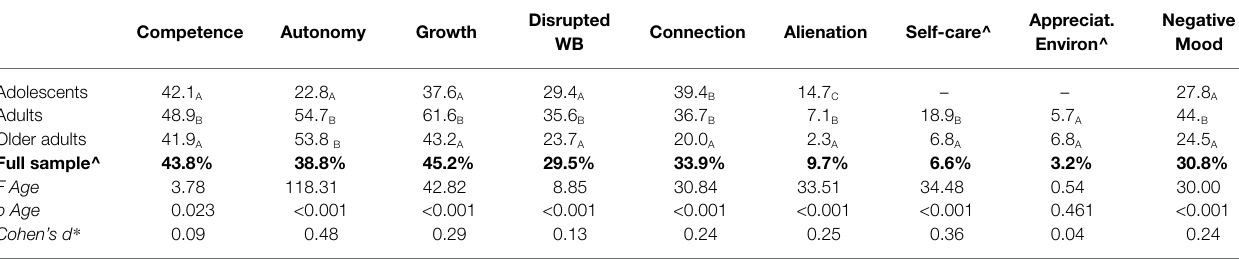
TABLE 1 | Frequencies of narrative codes for each of the three age groups and their differences across age